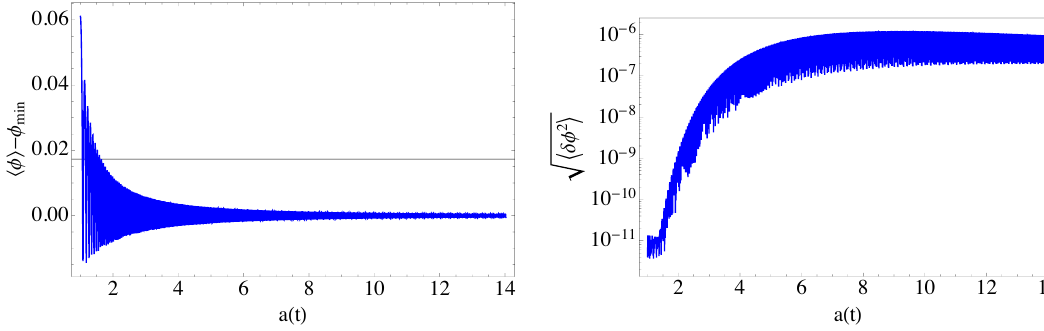
p h (cid:14)(cid:30) 2 i (bottom) as a function of